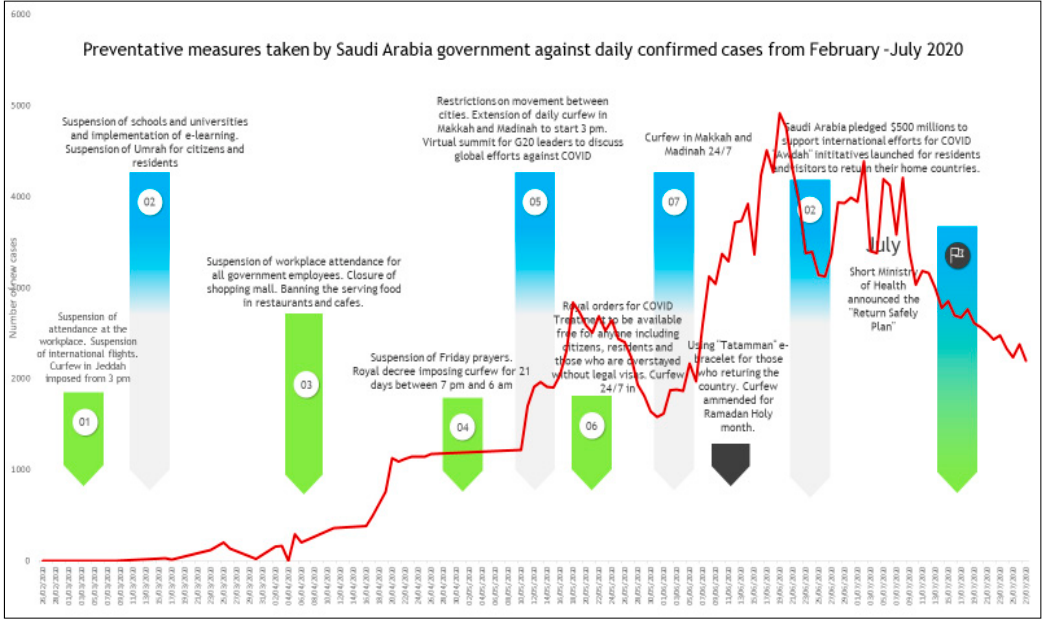
Figure 4. Timeline of preventive measures taken by the Saudi Arabian government compared with the daily COVID-19 confirmed new cases recorded from February 3–July 21 2020.